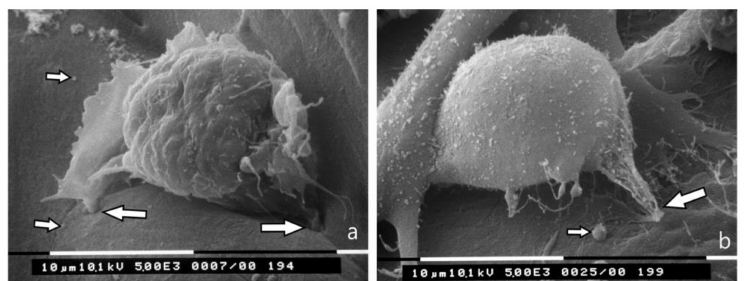
Figure 4. 3D Matrigel (3.0 µ g/mL) cell cultures analyzed by SEM. ( a ) MCF-7 cell lying on a thick layer of Matrigel shows very few microvilli and no microvesicles. Two invadopodia penetrating the Matrigel develop from the ventral side of the cell (large arrows). A few exosomes and microvesicles are shed on the Matrigel surface (small arrows). Bar 10 µ m; ( b ) An MDA-MB-231 cell with few microvilli and microvesicles shows invadopodia (large arrow) penetrating into the thickness of Matrigel. Two adjacent elongated cells with few microvesicles are also visible. Few exosomes and microvesicles (small arrow) shed from MDA-MB-231 cells are present on the Matrigel surface next to the cells. Bar 10 µ m.